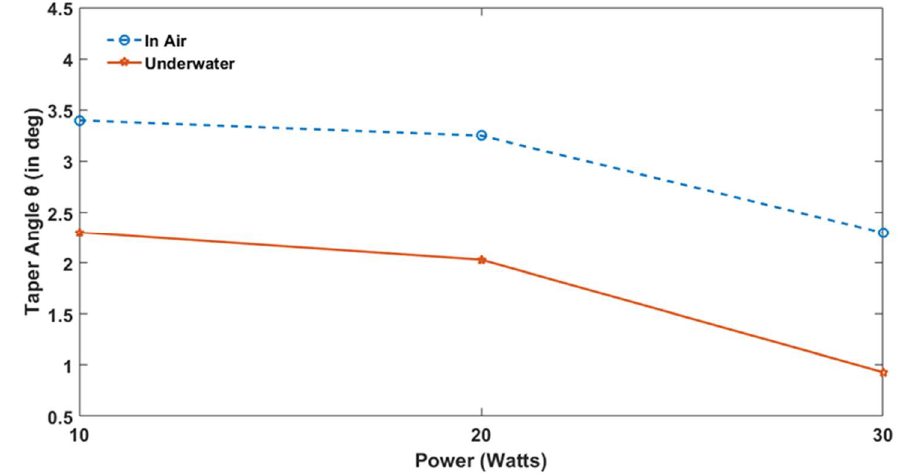
Figure 9. Variation in taper angle with respect to laser power in the LBMM process and LA-LBMM process under distilled water.